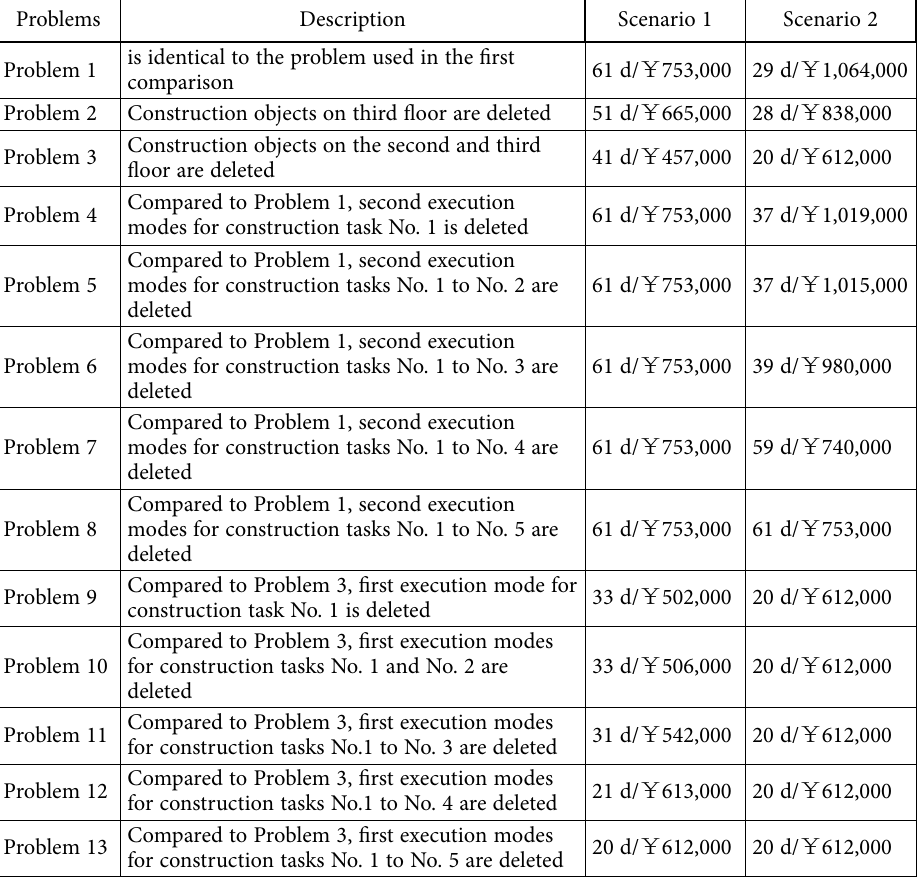
Table 6. Information of testing